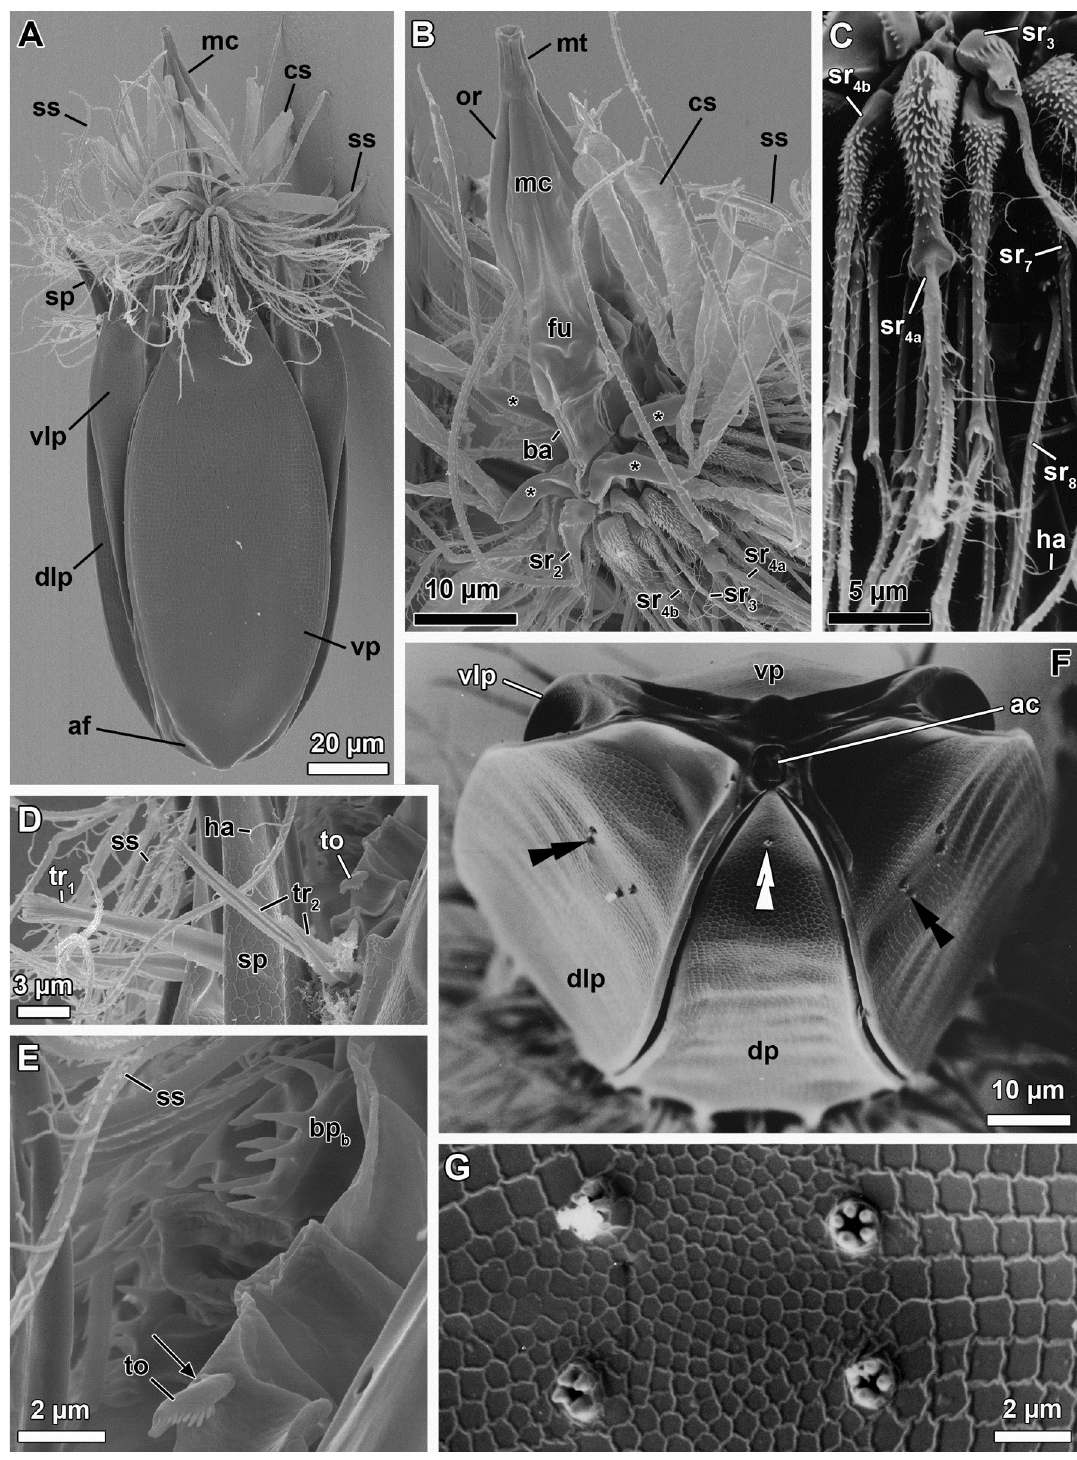
Fig 14. Scanning electron micrographs of a paratypic adult male of Nanaloricus mathildeae sp. nov. (A) Overview of the extended specimen, ventral view, anterior faces up. (B) Close up of the anterior body region. Note the broad, multiform clavoscalids (cs). Clavoscalid bases are marked with asterisks ( � ). (C) Close up of spinoscalids from different rows, each with distinct gross morphology. Note the numerous long hairs (ha) scattered along the length of the various spinoscalids. (D) Close up of a dorsolateral single trichoscalid (tr 1 ) and a midlateral (right-hand side) double trichoscalid (tr 2 ). Note the relatively small sensory organ (to) of the double